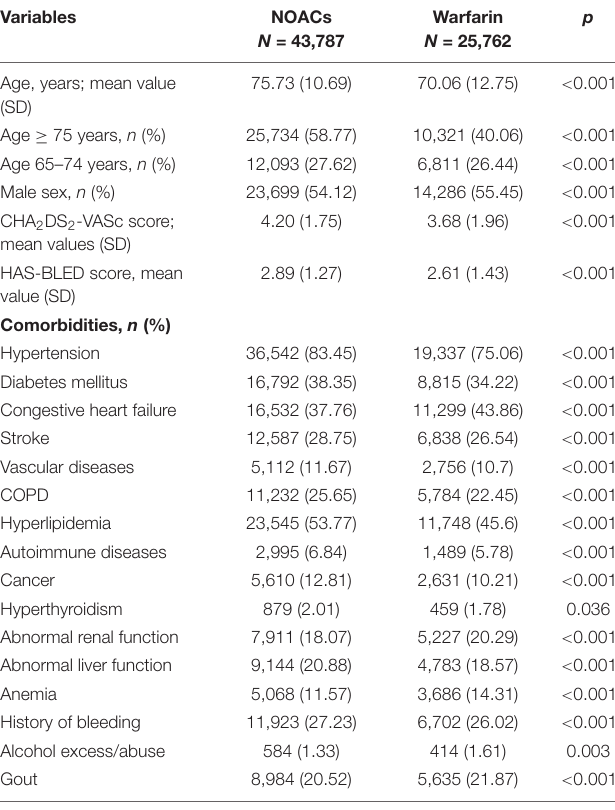
TABLE 1 | Baseline characteristics of NOAC and warfarin groups.